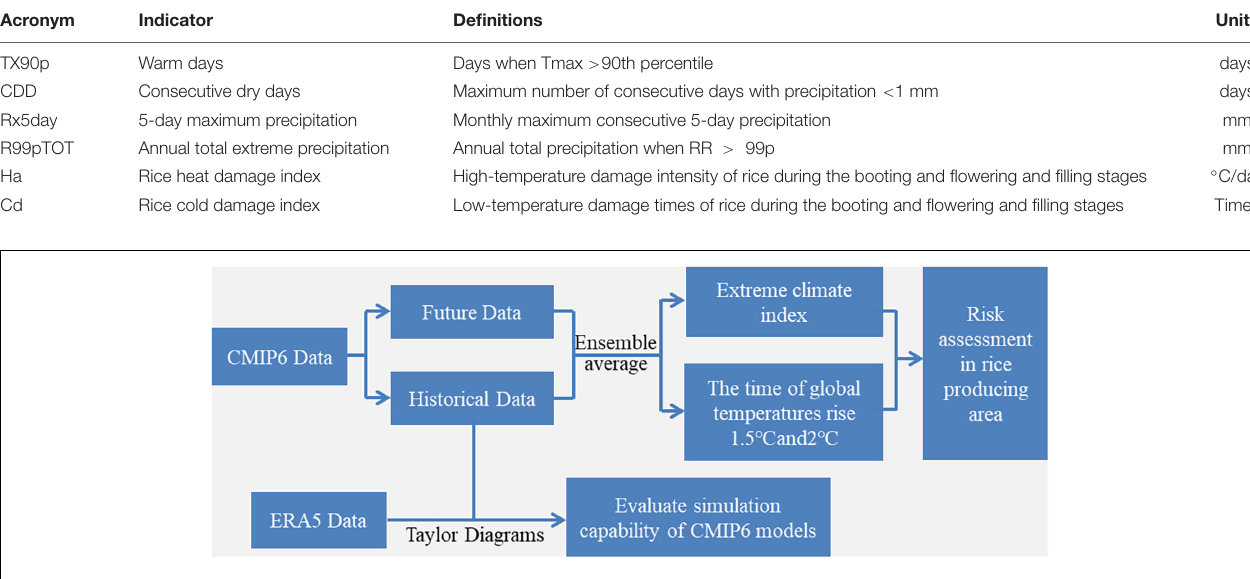
Frontiers in Earth Science |